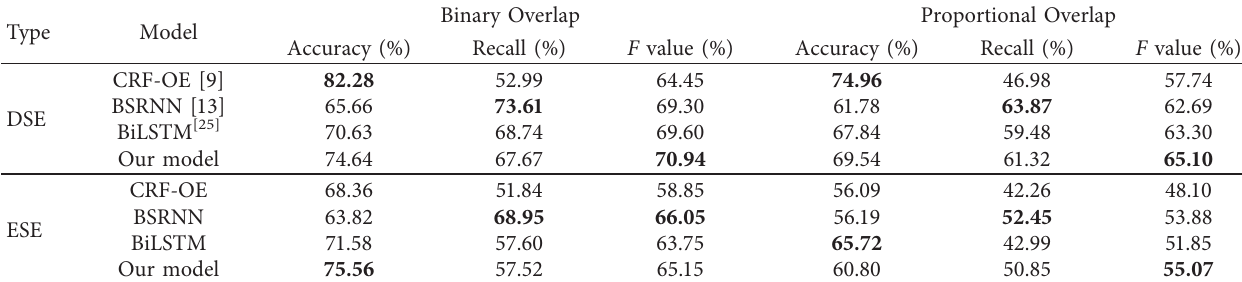
Table 5: The contrast of three expression extraction models and baseline methods in this